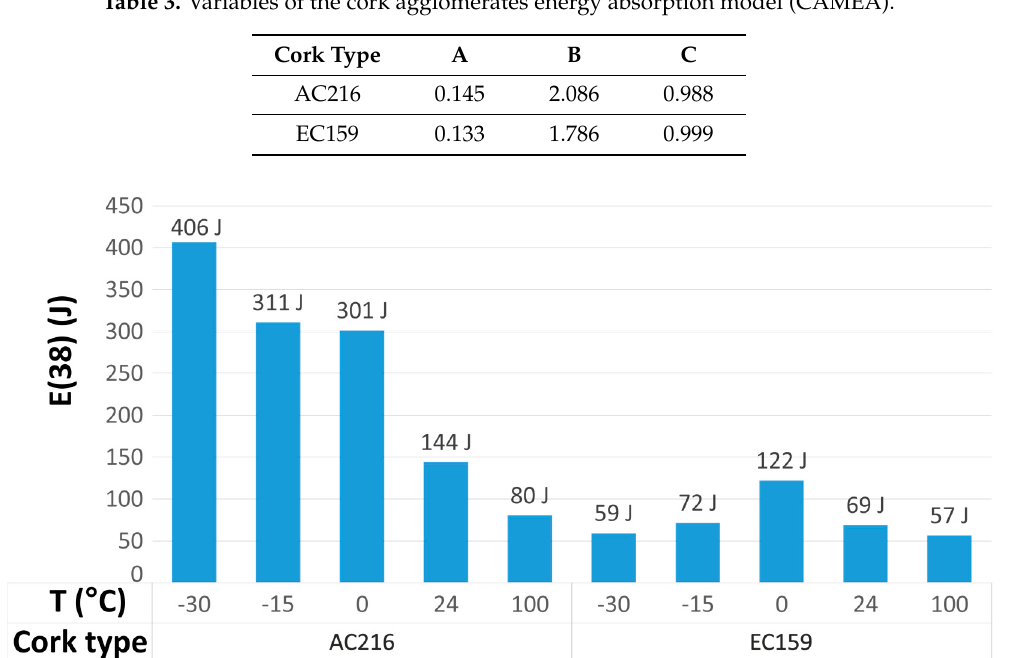
Table 3. Variables of the cork agglomerates energy absorption model (CAMEA).